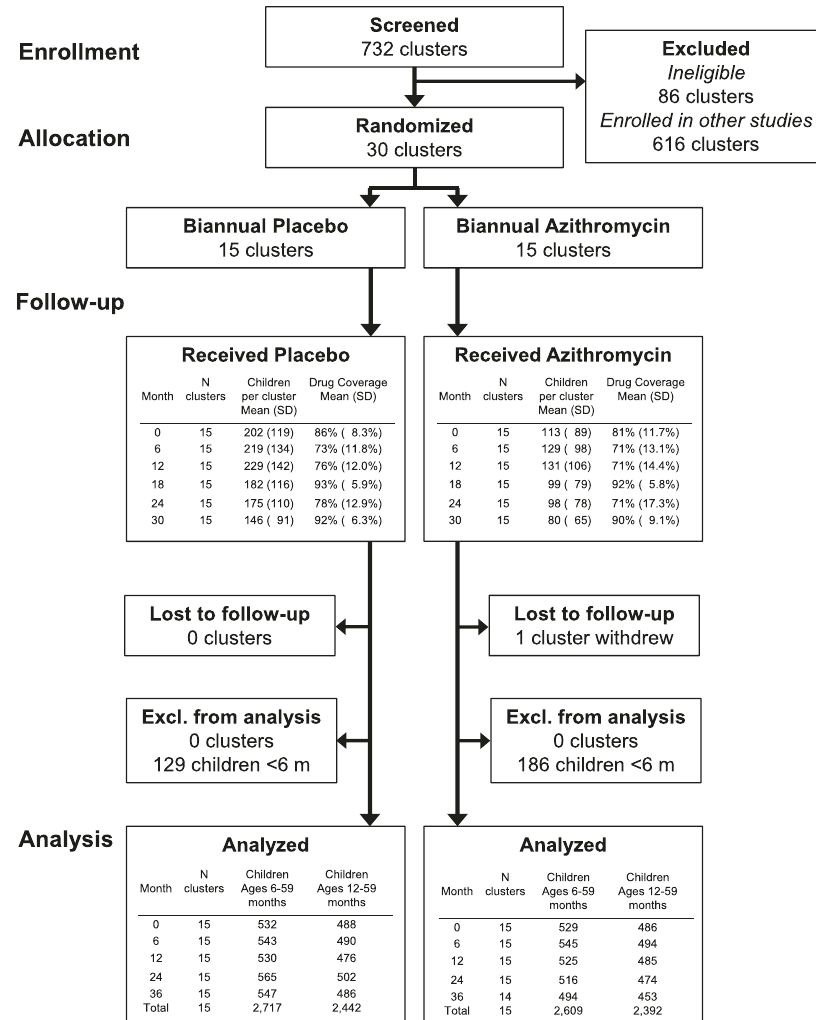
Fig. 1 Study participant fl ow. Thirty community clusters were randomly selected from a larger pool of clusters enrolled in the overall MORDOR Niger trial. A random sample of 40 children ages 1 – 59 months per community were selected for serological monitoring. Children <12 months old (malaria antigens) and <6 months old (other pathogens) were excluded from the primary analyses based on a pre-speci fi ed criteria to exclude maternal IgG contributions. Created with notebook